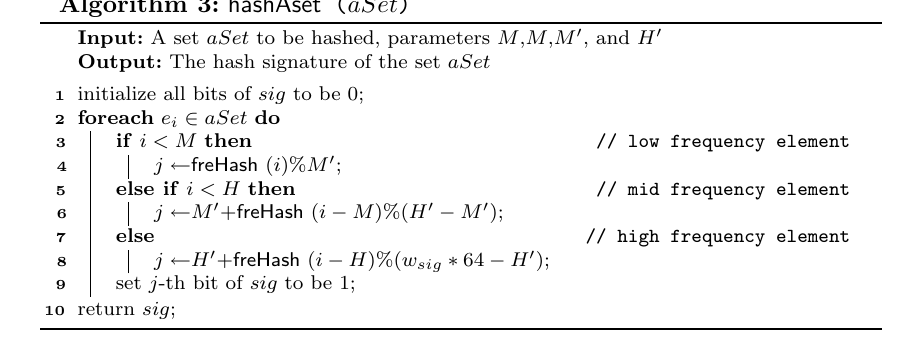
Algorithm 3: hashAset ( aSet